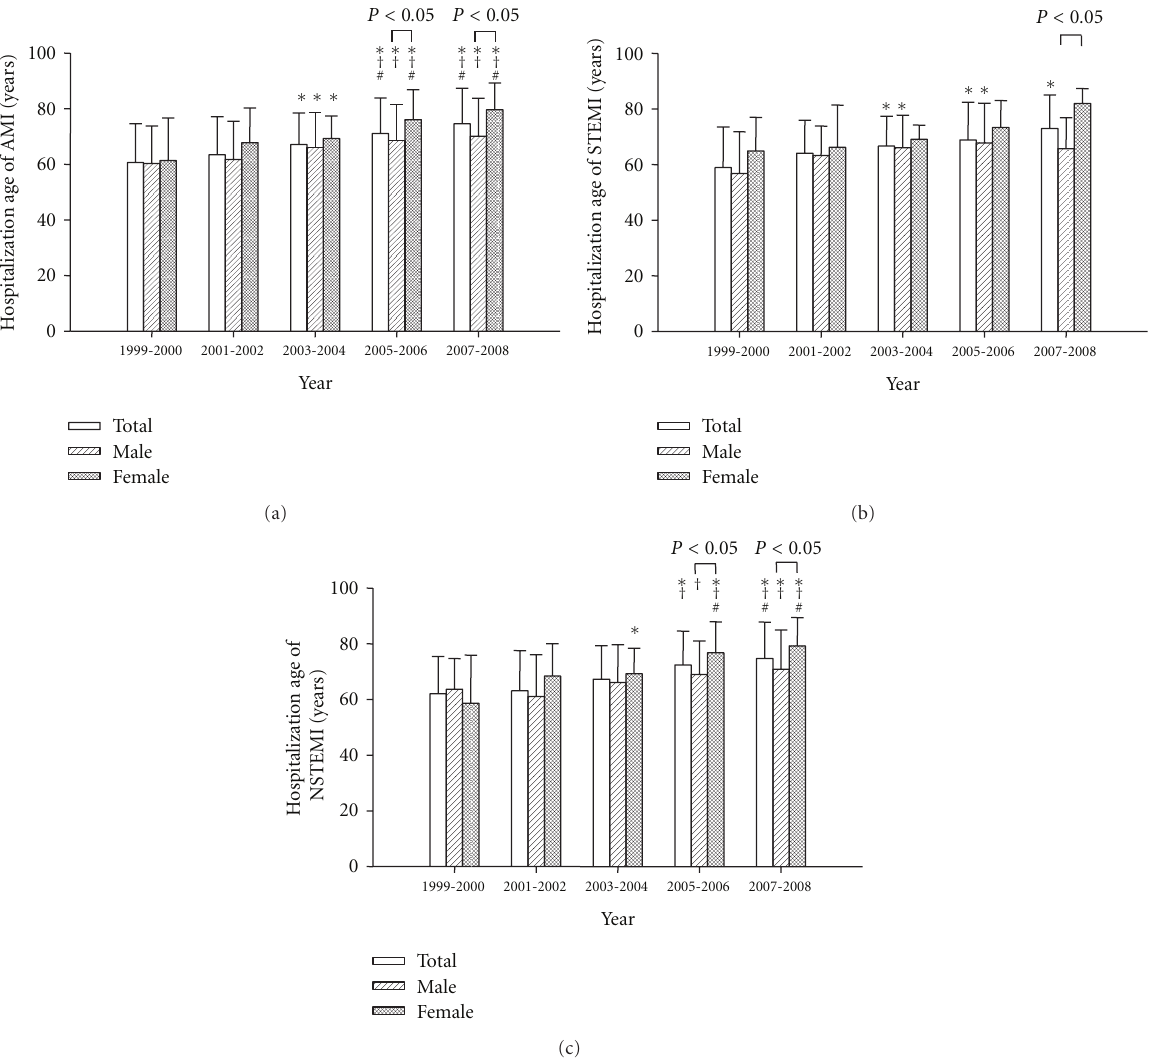
Figure 2: Hospitalization age of total, male and female acute myocardial infarction (AMI, (a)), ST elevation MI (STEMI, (b)), or non-ST elevation MI (NSTEMI, (c)) from 1999 to 2008. ∗ P < 0 . 05 versus 1999 ∼ 2000, † P < 0 . 05 versus 2001 ∼ 2002, and # P < 0 . 05 versus 2003 ∼ 2004. Only the patients with first onset AMI within the year were